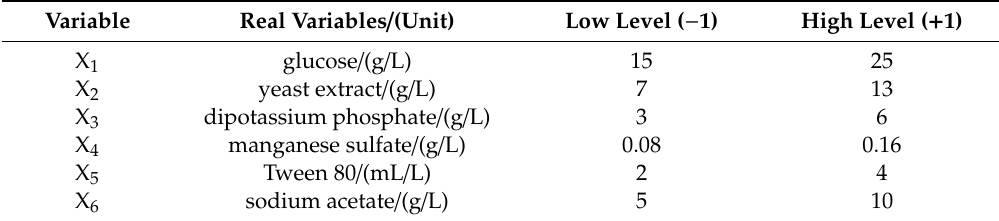
Table 2. Range of di ff erent factors investigated with Plackett-Burman.